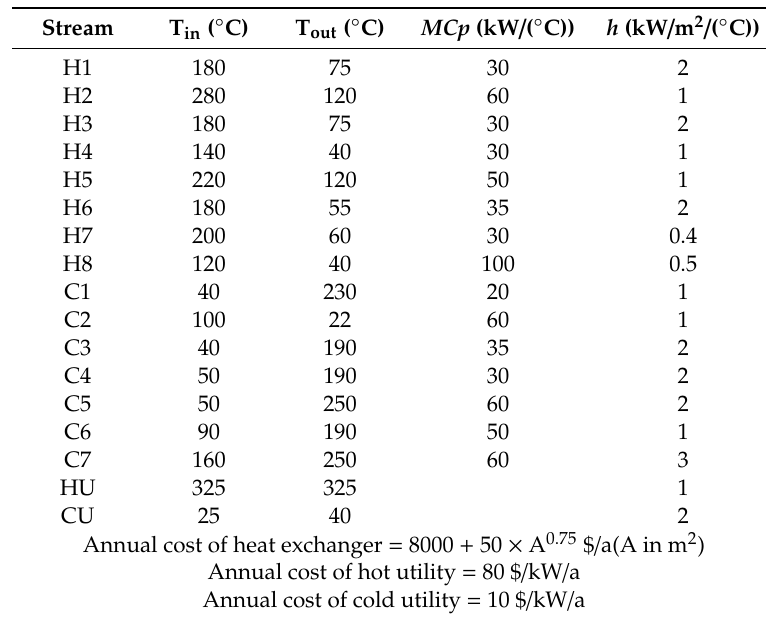
Table 5. Stream, cost, and parameters of case 3.